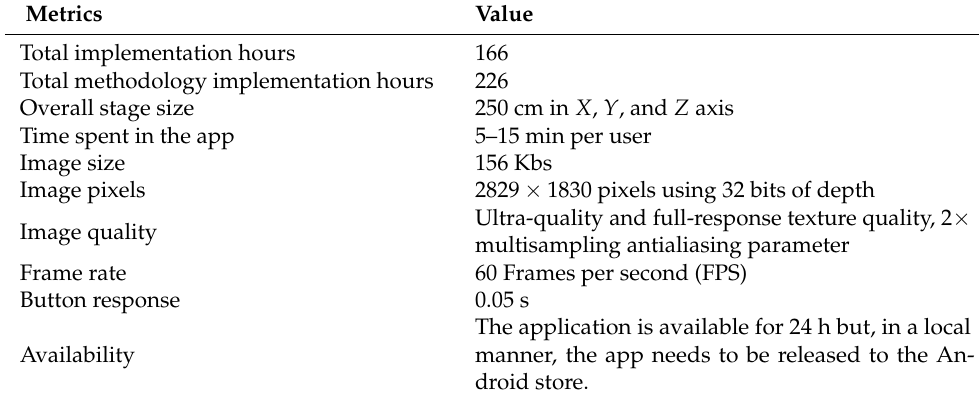
Table 2. Evaluation